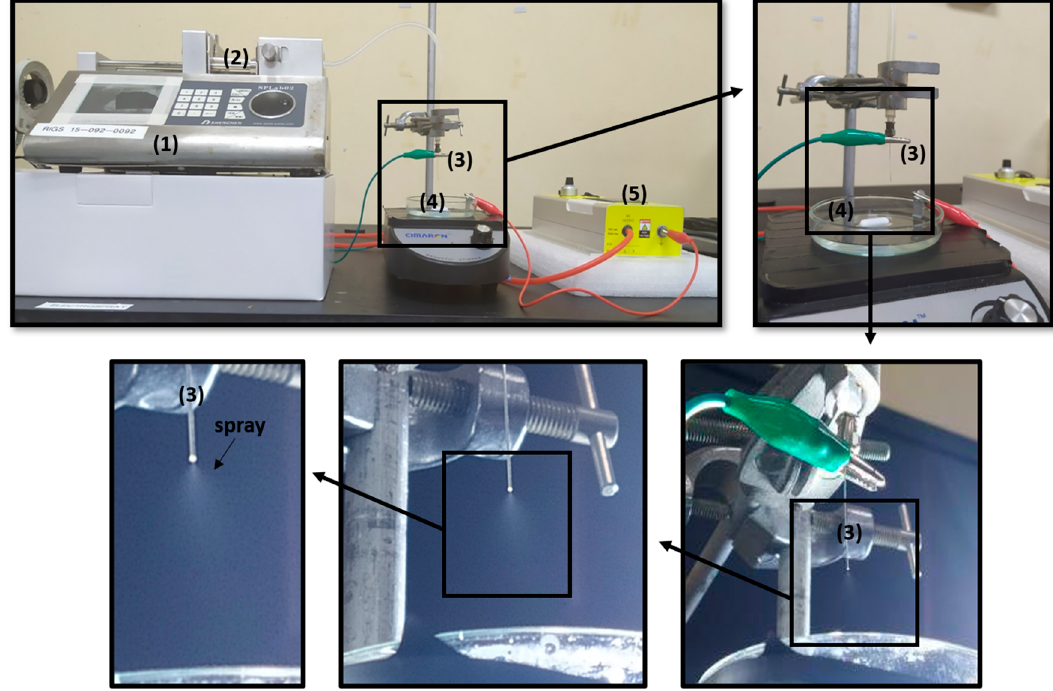
Figure 1. Experimental setup for electrospray fabrication of calcium alginate nanoparticles in cone jet mode: ( 1 ) syringe pump, ( 2 ) syringe, ( 3 ) nozzle tip, ( 4 ) collector (gelling bath), and ( 5 ) high voltage power supply.